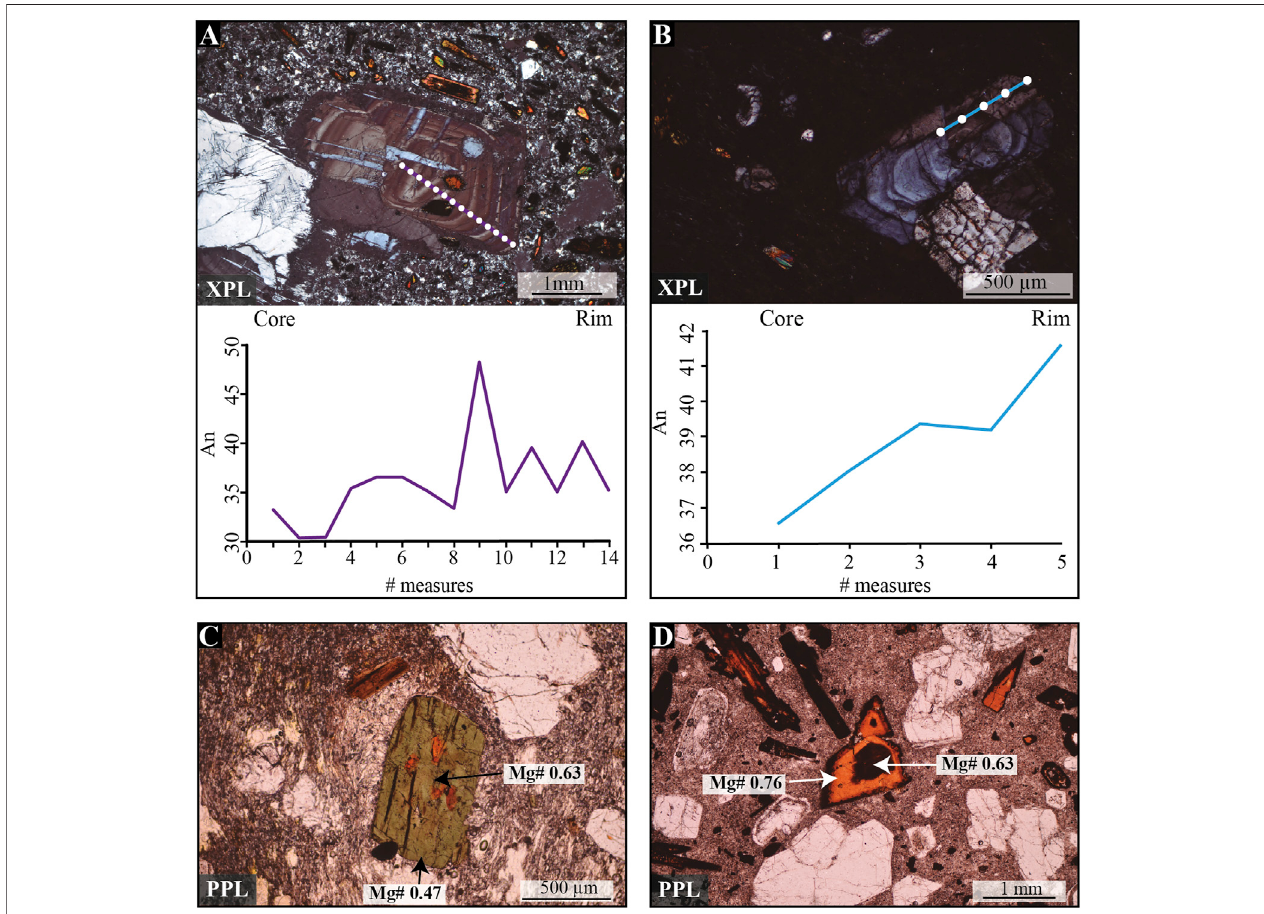
FIGURE5| Compositionalzonationinplagioclaseandamphibolecrystals. (A) OscillatoryzonationinplagioclasecrystalfromtheGuadalupevolcano(R:rimandC: Core); the white dots represent the measurement points. (B) Reverse zonation in the plagioclase crystal from the El Escondido volcano (R: rim, C: Core); the white dots represent the measurement points. (C) Normal zonation in the tschermakitic amphibole crystal from El Escondido volcano. (D) Reverse zonation in the magnesiohastingsitic amphibole crystal from the Pela Huevos volcano.